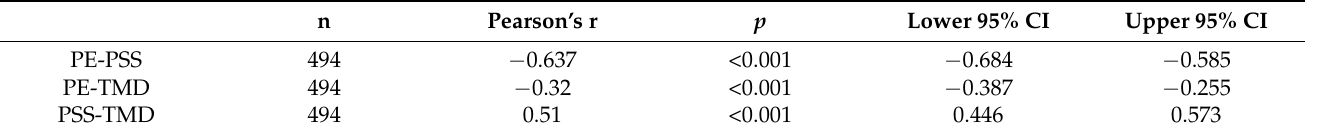
Table 2. Correlation analysis.